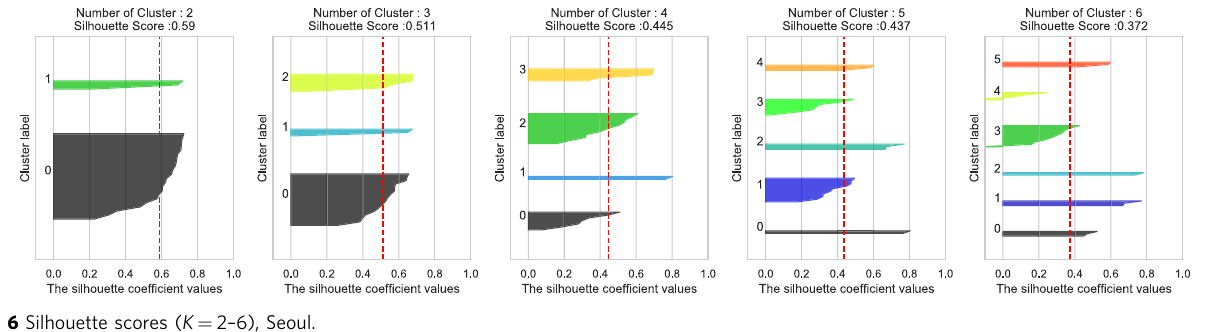
Fig. 6 Silhouette scores ( K = 2 – 6), Seoul.